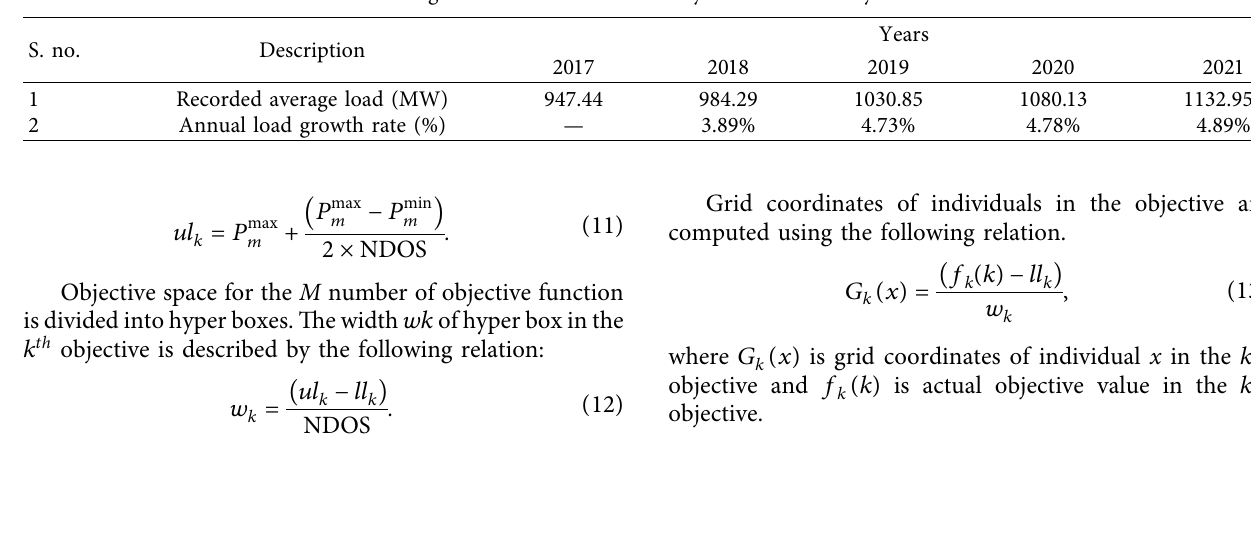
Figure 2: Basic structure of solar PV power plant. Table 8: Average load recorded in last fve years for the test system